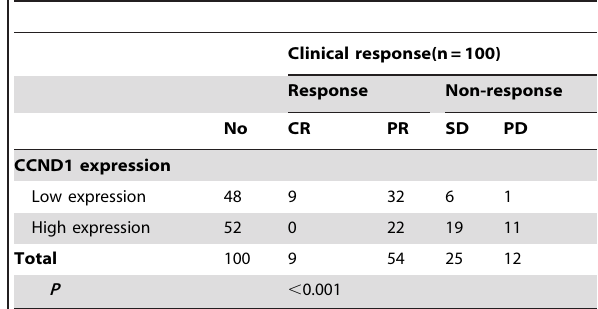
Table 3. CCND1 protein expression and clinical response in patients with HNSCC who were treated with cisplatin-based regimens.